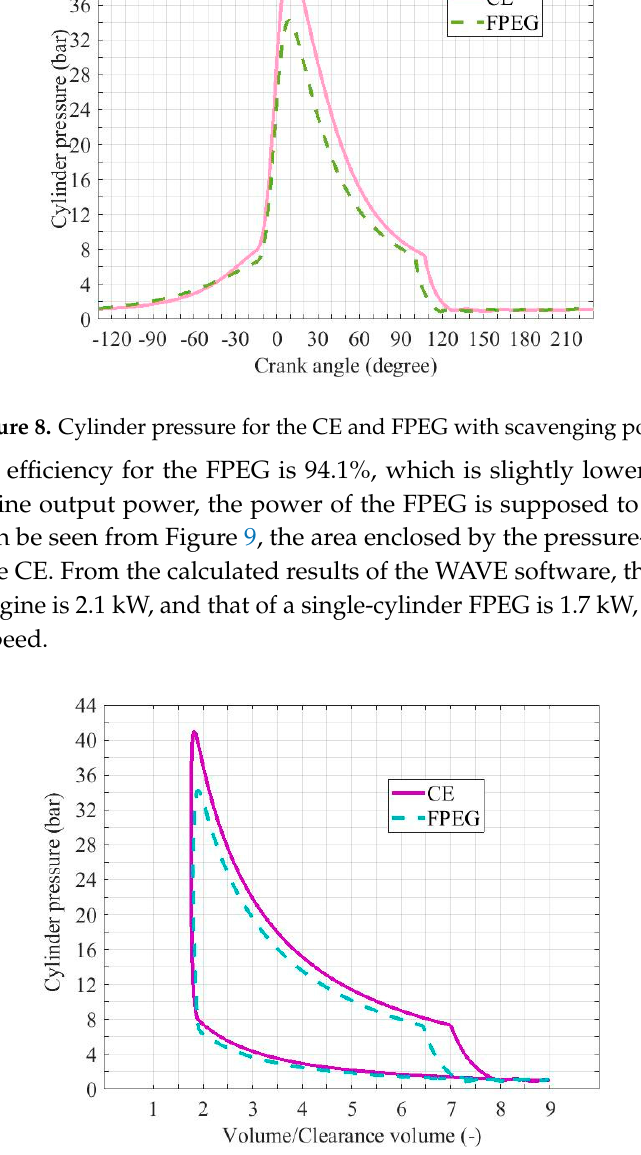
Figure 9. p-V diagram of FPEG with scavenging ports compared with CE.